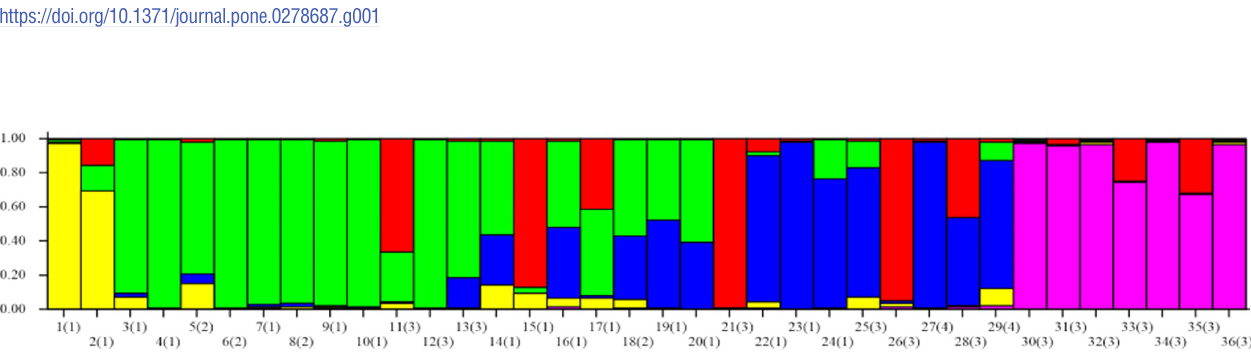
Fig 2. Genetic relatedness of smooth bromegrass genotypes analyzed by STRUCTURE program. Numbers on the y -axis indicate the membership coefficient. The color of the bar indicates the five sub-groups identified through the STRUCTURE program. Genotypes with the same color belong to the same group.